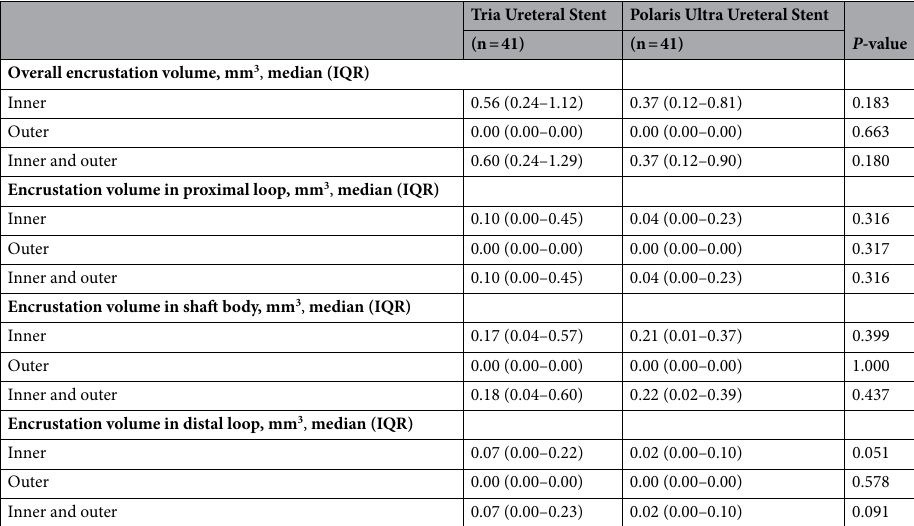
Tria Ureteral Stent Polaris Ultra Ureteral Stent